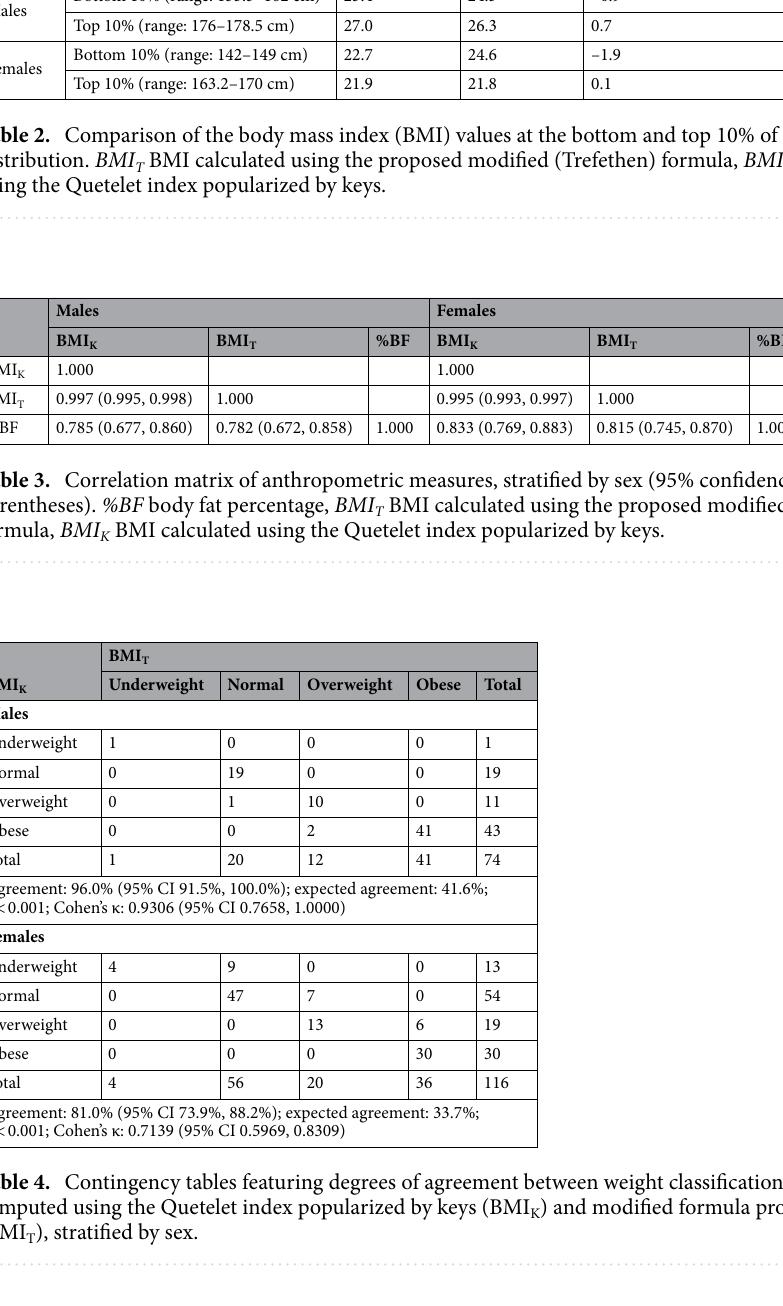
Table 3 shows the correlation matrix that includes both BMI types and %BF, stratified according to sex. High correlation exists between BMI K and BMI T , as well as between %BF and BMI K , and between %BF and BMI T . The correlations, however, tended to be higher among females, albeit not significantly, basing on the overlapping 95% CIs. The crosstabulations in Table 4 show the degrees of agreement between weight classifications based on BMI K and BMI T . The proportion of agreement was significantly lower among females (81.0%; 95% CI 73.9%, 88.2%) compared to males (96.0%; 95% CI 91.5%, 100.0%), despite the agreement statistic being substantial (κ = 0.7139; 95% CI 0.5969, 0.8309). On the other hand, there was almost perfect agreement between the two weight clas- sifications among males (κ = 0.9306; 95% CI 0.7658, 1.0000). For both sexes, linear and quadratic relationships between %BF and both BMI values (BMI K and BMI T ) were analysed using robust polynomial regression, as discussed earlier. The resultant Wald F statistics when setting the squared BMI term to zero were statistically significant for both BMI K (males: F 1,65.0 = 4.81, p = 0.032; females: F 1,107.7 = 16.37, p < 0.001) and BMI T (males: F 1,65.0 = 4.23, p = 0.044 ; females: F 1,107.7 = 14.81, p < 0.001), indicating that the squared BMI term is a necessary predictor of %BF.